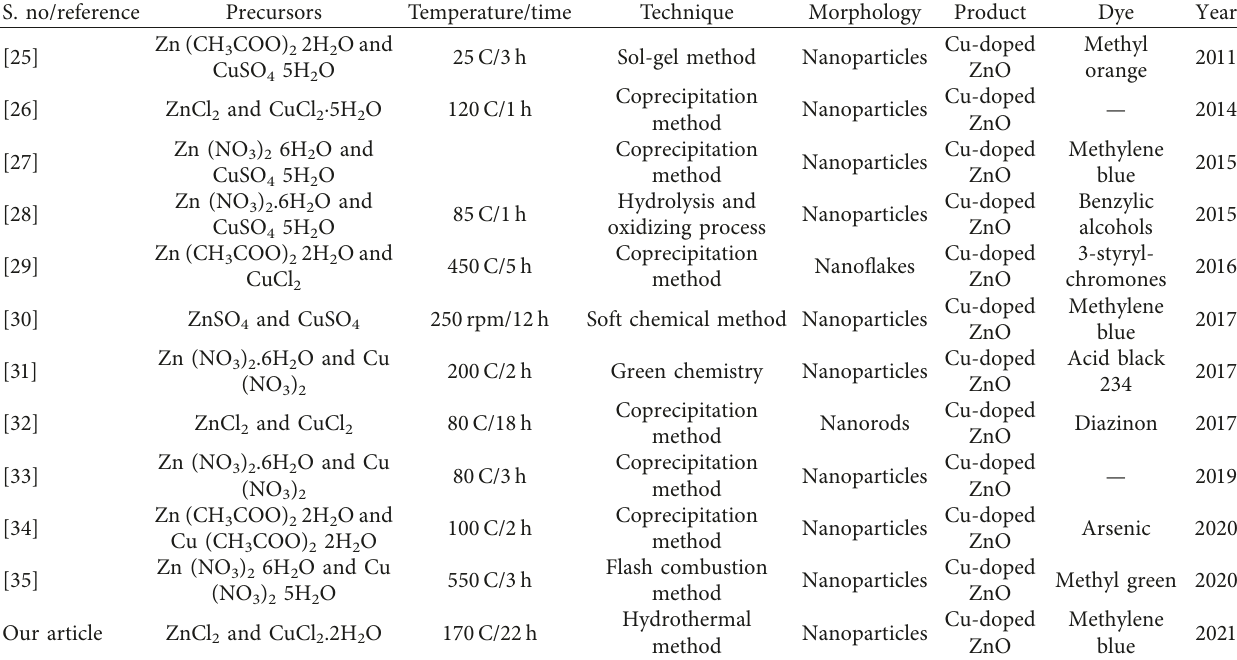
Table 1: Comparison of various parameters of Cu-doped ZnO NPs with published articles. S. no/reference